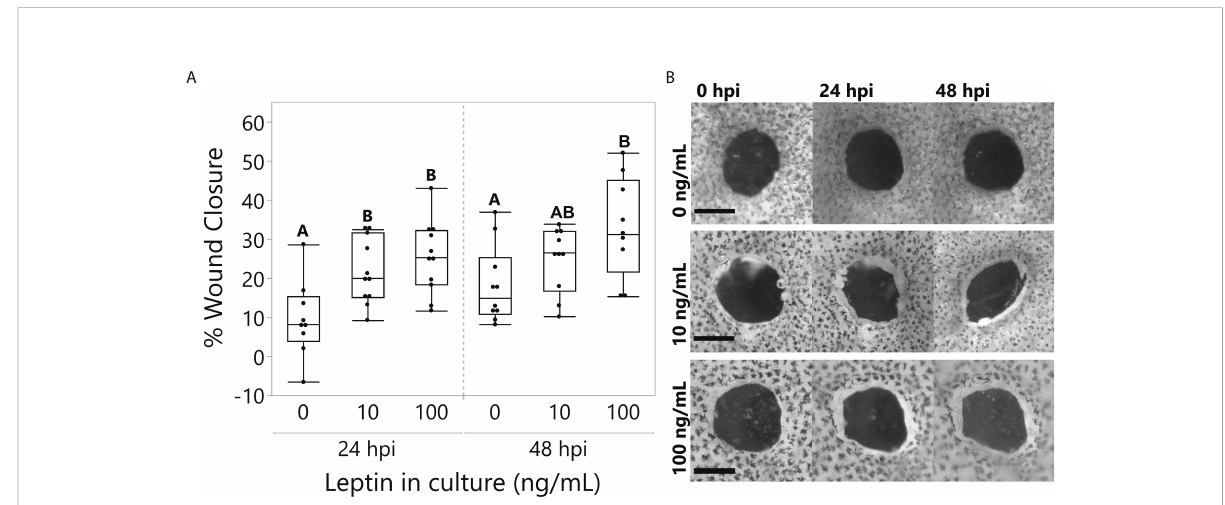
FIGURE 5 Leptin treatment (0, 10, and 100 ng/ml) in culture media signi fi cantly improved wound healing in juvenile Xenopus laevis dorsal skin explants at 48 h of culture. (A) At 24 h, treatments at both 10 and 100 ng/ml signi fi cantly increased wound closure compared to the control, and by 48 h, the 100